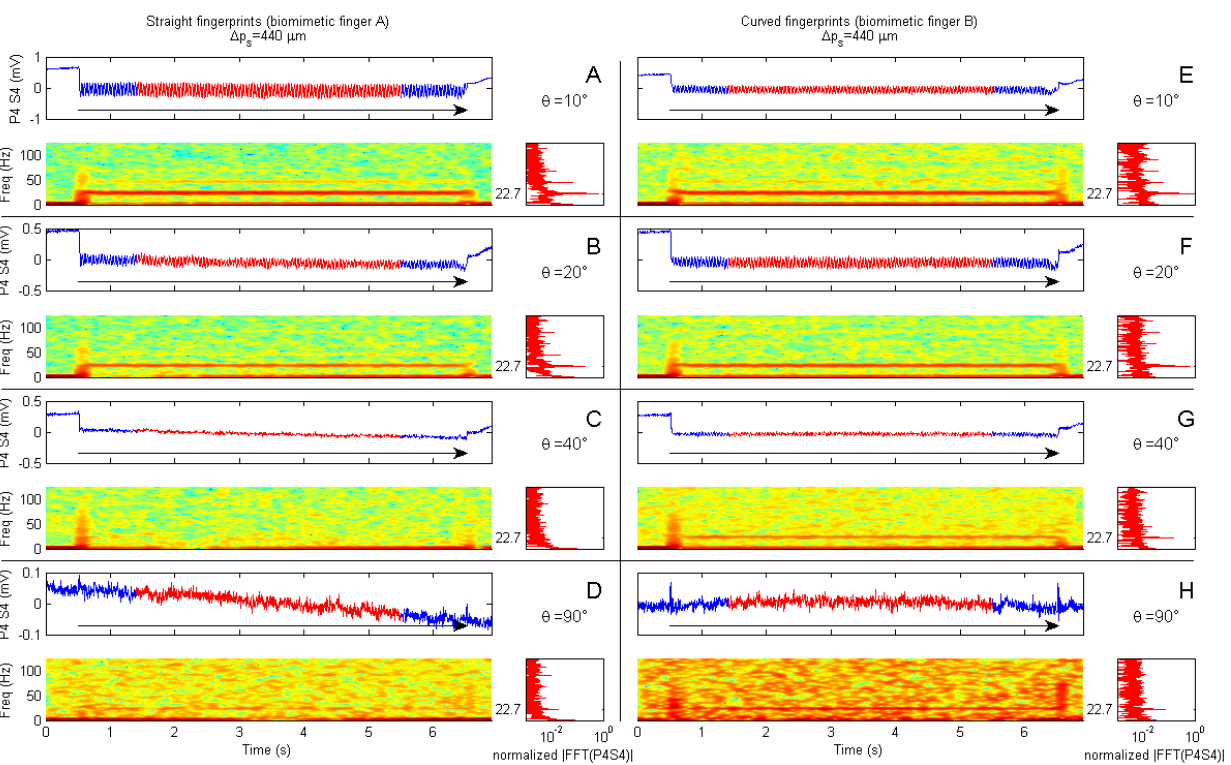
Figure 8. Encoding of stimulus spatial period Δ p as a function of biomimetic fingertip s rotation θ for both the prototypes with straight and curved fingerprints. Data belongs to Piezoresistor 4 of Sensor 4 of the biomimetic finger and was acquired while sliding at 10 mm/s (200 mN indentation force) the 440 μ m periodic stimulus over the biomimetic finger with straight fingerprints ( Panels A to D ) and with curved fingerprints ( Panels E to H ). According to Equation (1), the expected principal frequency was 22.7 Hz. A description of each row of the subplots is provided within Figure 7. The plotted results are obtained by rotating the finger of an angle θ set to 10° ( A , E ), 20° ( B , F ), 40° ( C , G ) and 90° ( D , H ) with respect to the stimulus sliding